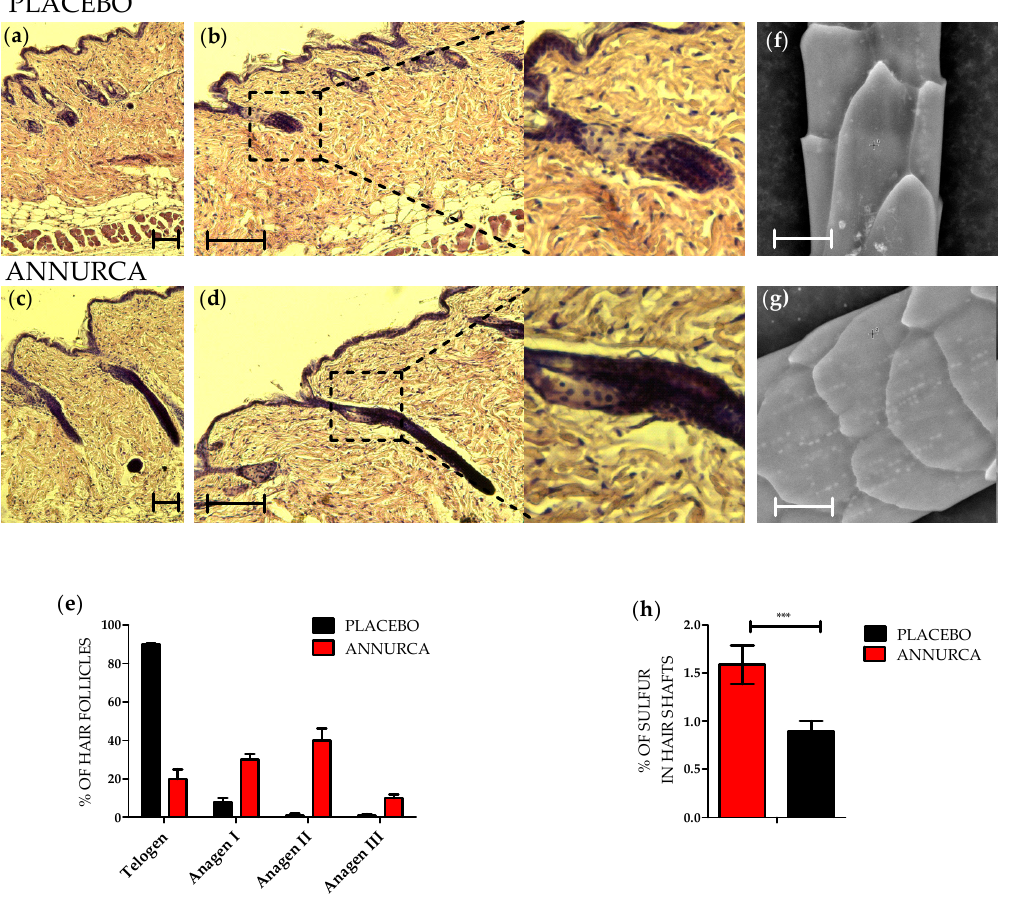
Figure 1. AAE induces early exit from telogen and increases keratin content of hair shafts in murine HFs. C57BL/6 mice were treated topically with a foam supplemented either with AAE or with a placebo. Foams were applied on the dorsal skin of 7-week-old mice. After 4 weeks of treatment, mice were sacrificed and HFs classified following morphological criteria. Haematoxylin-eosin staining of HFs of mice treated with placebo ( a – b ) showing HFs mostly in Telogen/AnagenI phase. HFs of mice treated with AAE appeared in a later stage of Anagen, mostly Anagen II ( c – e ). ( f – h ) SEM (SEM-EDX) analysis of hairs extracted from mice treated with placebo ( f ) or with AAE ( g ). SEM quantitative analysis indicates ( h ) an increase in Sulfur concentration (cystine, methionine, cysteine and cysteic acid all abundant amino acids of hair keratins) in hairs of mice treated with AAE. Values in € and ( h ) are reported as mean ± SEM ( n = 8, *** p < 0.001). Scale bars in a-d correspond to 200 µ m. Scale bars in ( f ) and ( g ) correspond to 10 μ m.